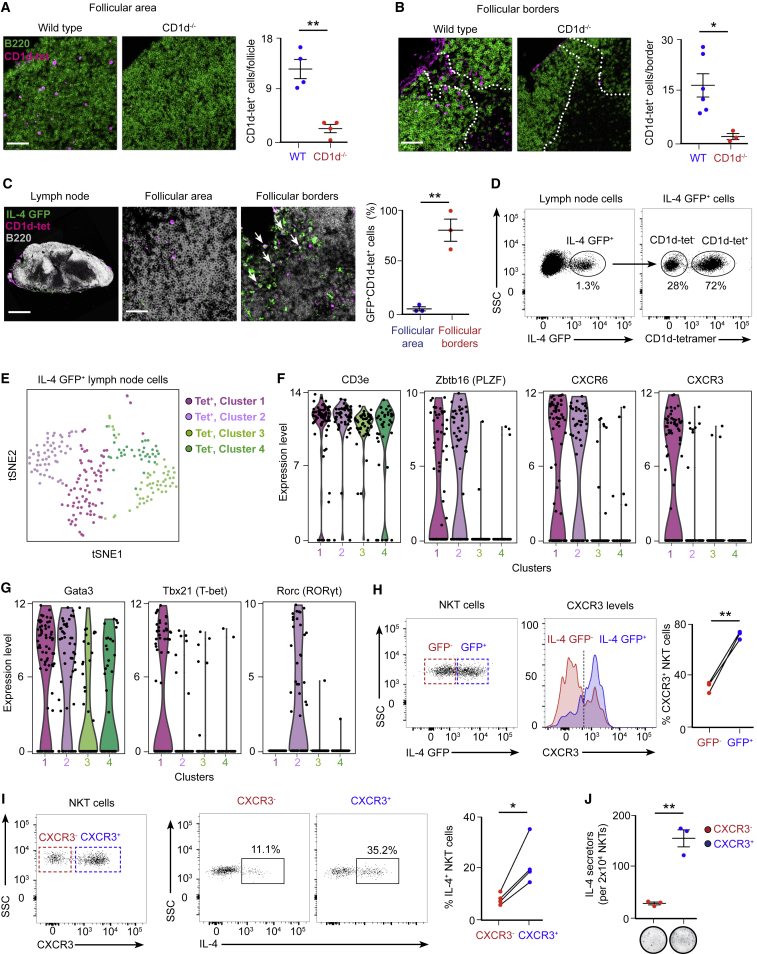
The Early IL-4 Wave Is Localized at the Periphery of B Cell Follicles(A–C) Confocal microscopy analysis of (A and B) wild-type and CD1d−/− and (C) IL4-GFP mice on day 3 of influenza infection. Lymph nodes were labeled with CD1d tetramer (magenta) and anti-B220 antibody (green in A and B and white in C). The arrows in (C) indicate CD1d tetramer+ cells expressing IL-4 (IL-4 GFP, green). Scale bars, 300 μm (lymph node) and 60 μm (section).(D) Flow cytometry analysis of IL-4 GFP+ cells in mediastinal lymph nodes on day 3 of influenza infection, showing CD1d-tet− and CD1d-tet+ cells.(E) t-SNE plots of CD1d-tet− and CD1d-tet+ subsets. The CD1d-tet+ population separates into two clusters (1, dark purple; 2, light purple), as does the CD1d-tet− population (3, light green; 4, dark green).(F and G) Expression distribution (violin plots) in each population (horizontal axes) for (F) CD3e, Zbtb16, CXCR6, and CXCR3 and (G) Gata3, Tbx21, and Rorc. Expression levels are log2(tpm+1).(H) Flow cytometry analysis of CXCR3 levels in IL-4-GFP− (red) and GFP+ (blue) NKT cells on day 3 of influenza infection. Lines connect cells from the same mouse.(I) Flow cytometry analysis of IL-4 production by CXCR3− (red) and CXCR3+ (blue) NKT cells on day 3 of influenza infection. Lines connect cells from the same mouse.(J) ELISPOT analysis of IL-4-producing CXCR3− (red) and CXCR3+ (blue) NKT cells sorted on day 3 of influenza infection. Each dot represents pooled NKT cells from 6 mice.In graphs showing statistical analysis, data are representative of at least two independent experiments. Horizontal bars, mean; error bars, SEM. Student’s t test, ∗p < 0.05, ∗∗p < 0.01.